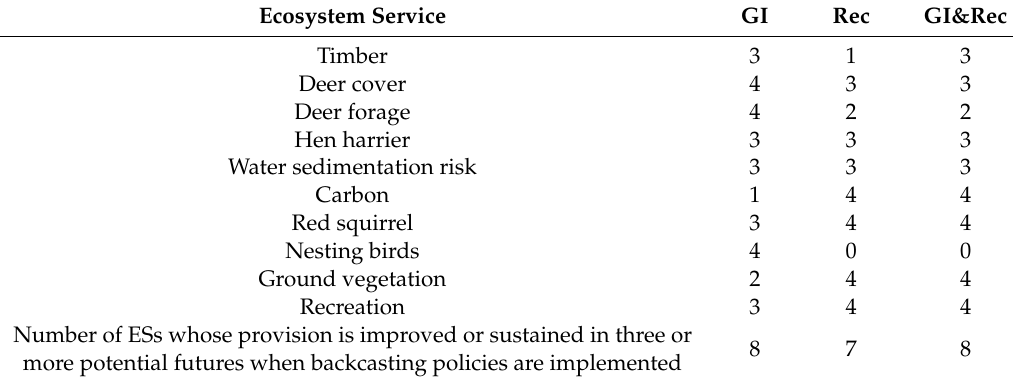
Table 13. The number of PFs (out of a maximum of four) where the average ES provision level (presented in Table 10) stays the same or moves towards the stakeholders’ desired ES level through the implementation of the backcasting policies om the NM